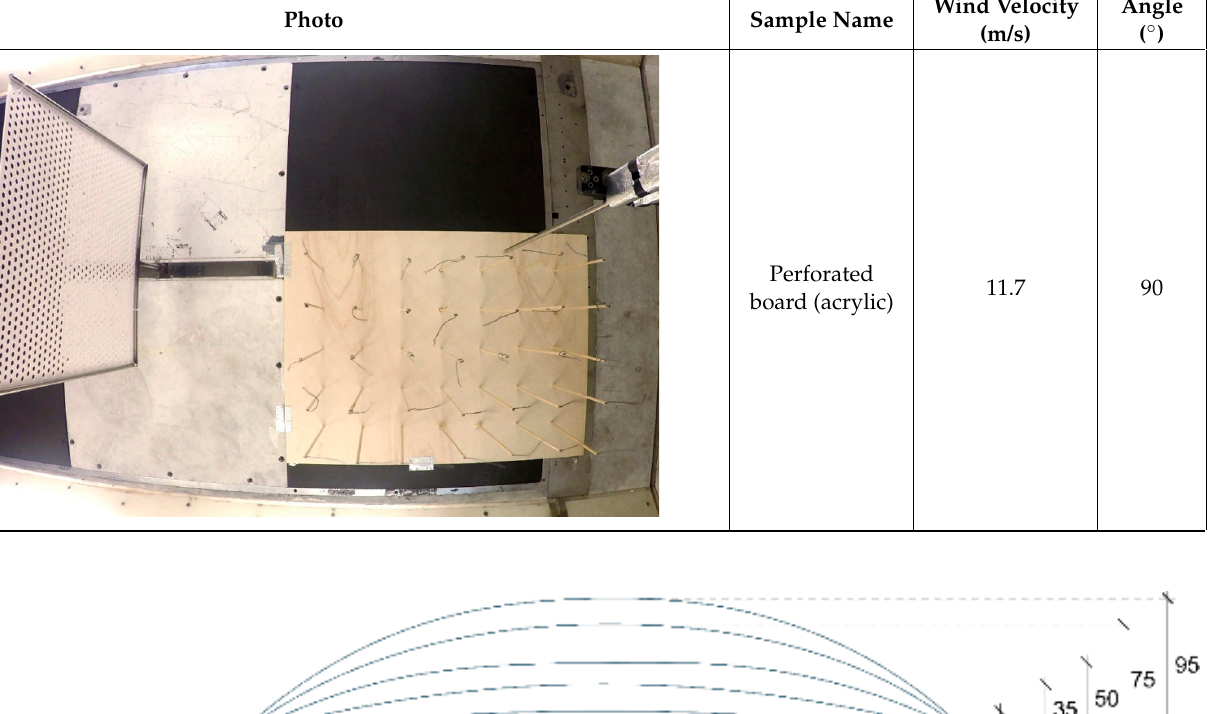
Figure 21. Estimated deformation shape of the knitted model drop-stitch 10%, based on the posi- tions of the center of the ellipses on the third row from the top at the different windspeeds from 0 to 15 m/s in photos from wind-tunnel tests. The values represent distances in millimeters.